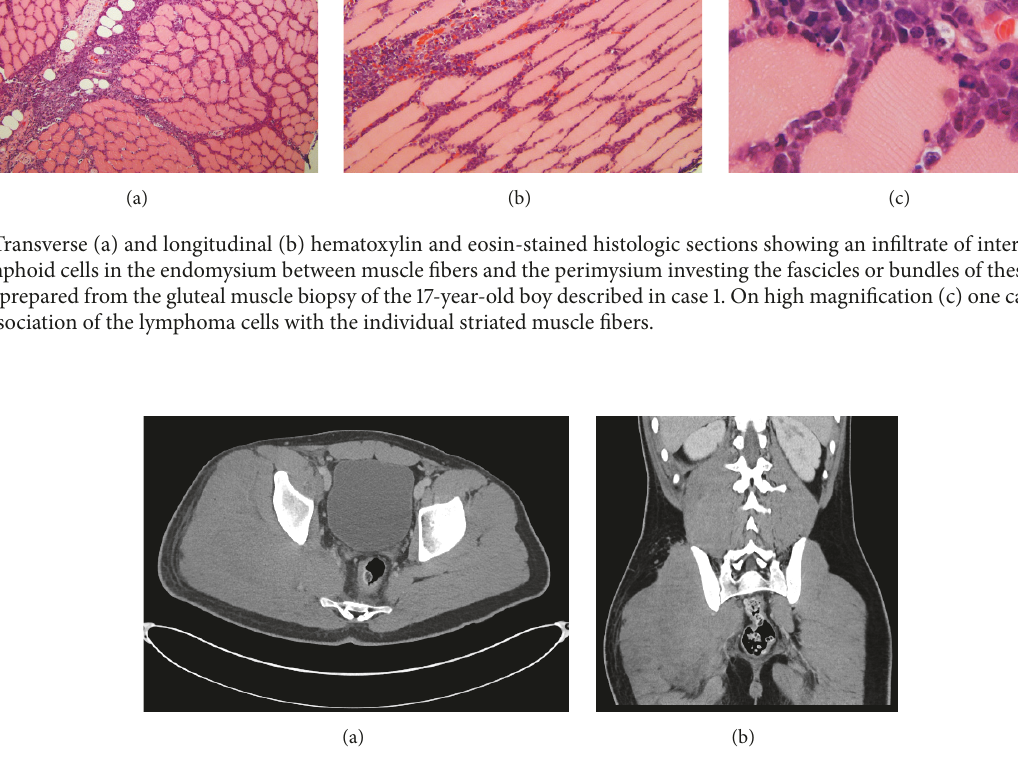
buttocks, an unusual site for lymph nodes. Regardless,